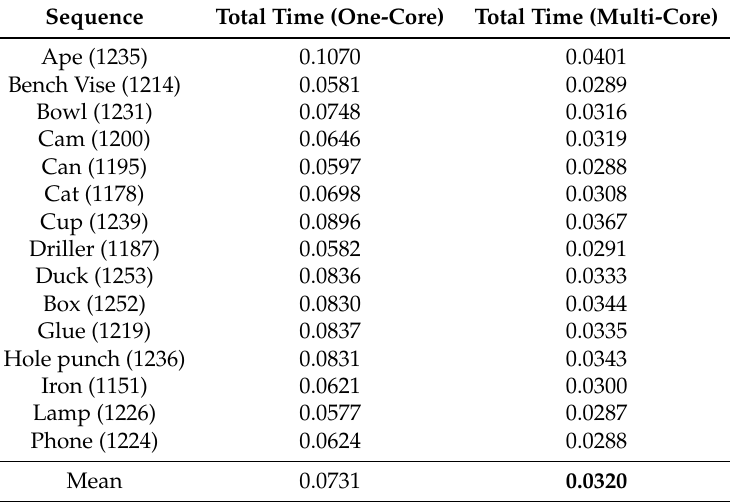
Table 3. Breakdowns of time in seconds of the detection and pose estimation algorithm on each of the sequences of the LINEMOD dataset. The algorithm implemented in the project (multi-core version) improved upon the performance of the LINEMOD++ algorithm by a factor of three